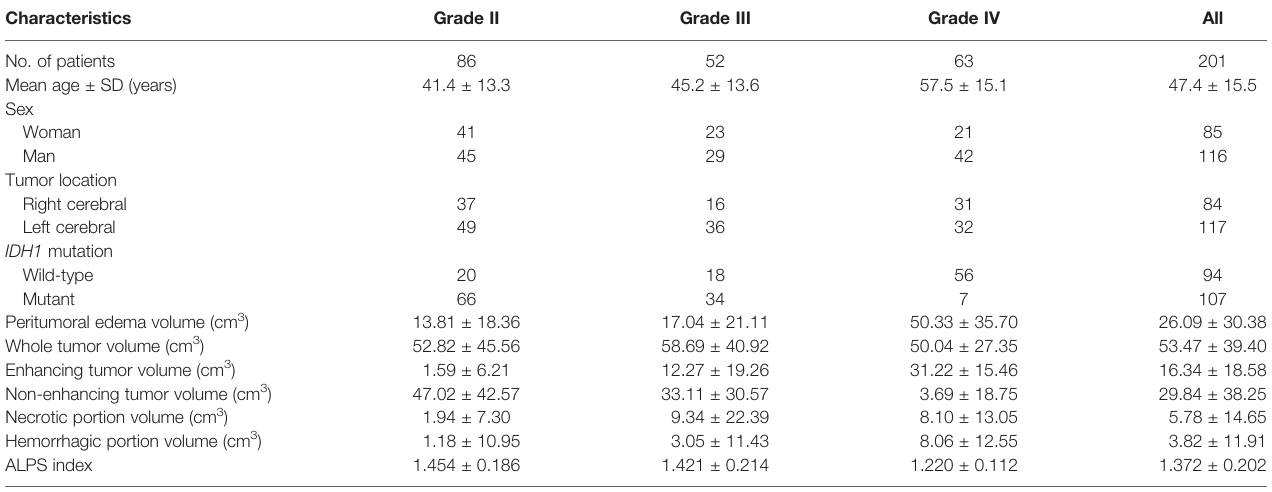
TABLE 1 | Patient characteristics and all